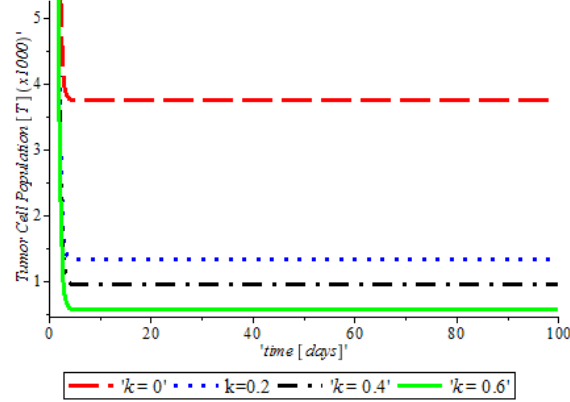
Figure 4. The variation of proportion of Estrogen level population for different values of k with other Figure 4: The variation of proportion of Estrogen level population for different value of k with parameters fixed. other parameters fixed